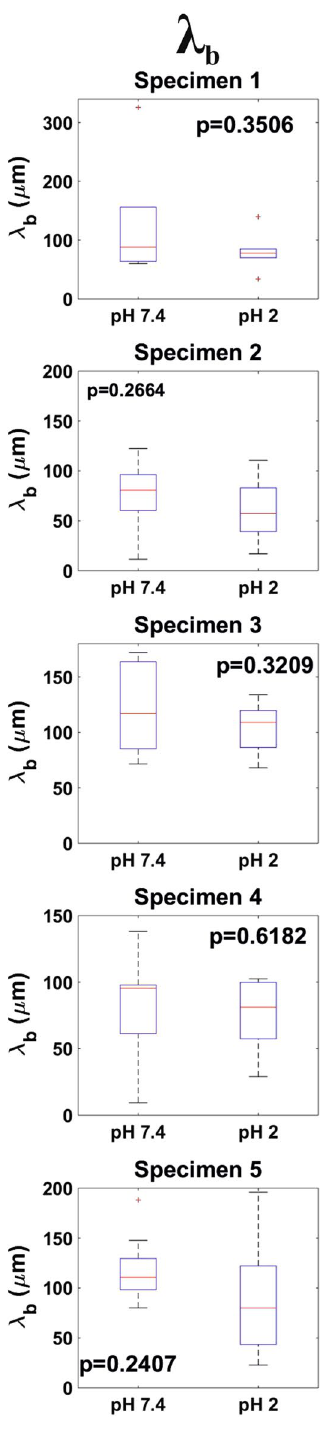
Figure 7. Distributions (n = 10) of λ b values obtained at both pH 7.4 and pH 2 for all investigated